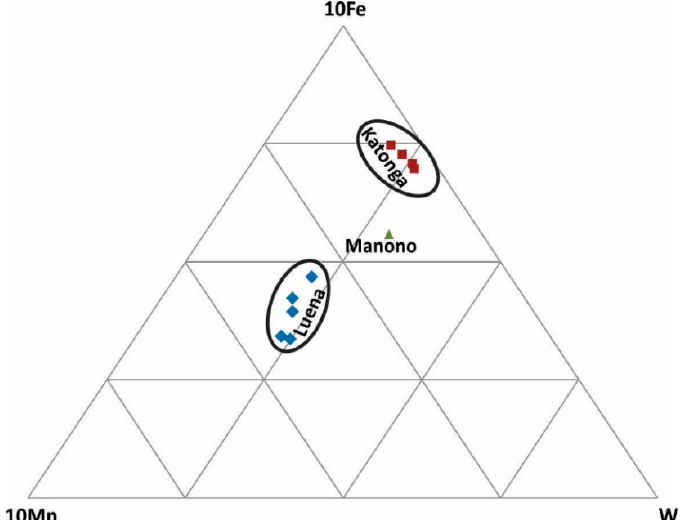
Figure 7. Discrimination of wolframite ore samples based on Fe, Mn, and W concentrations.